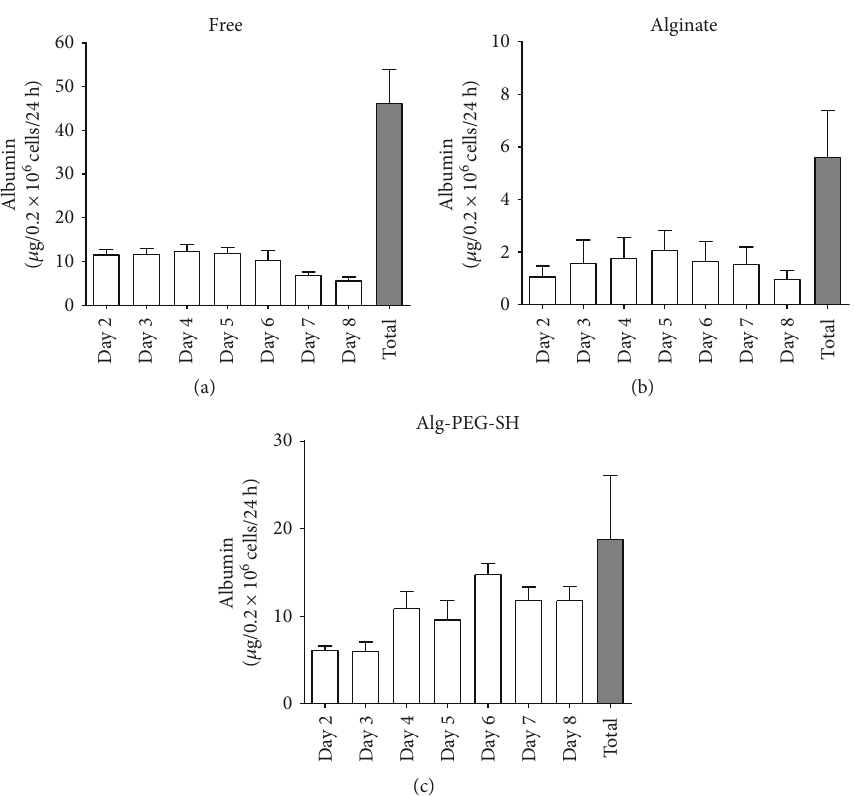
Figure 4: Albuminsecretion from free and microencapsulated hepatocytes. Albumin wasmeasured by ELISAin the supernatant of free ( n = 9 ) (a), alginate-encapsulated ( n = 3 ) (b), and Alg-PEG-SH-encapsulated ( n = 3 ) (c) hepatocytes. White bars represent albumin secretion during 24h from day 2 to day 8, and grey bars represent the total albumin secreted during 8